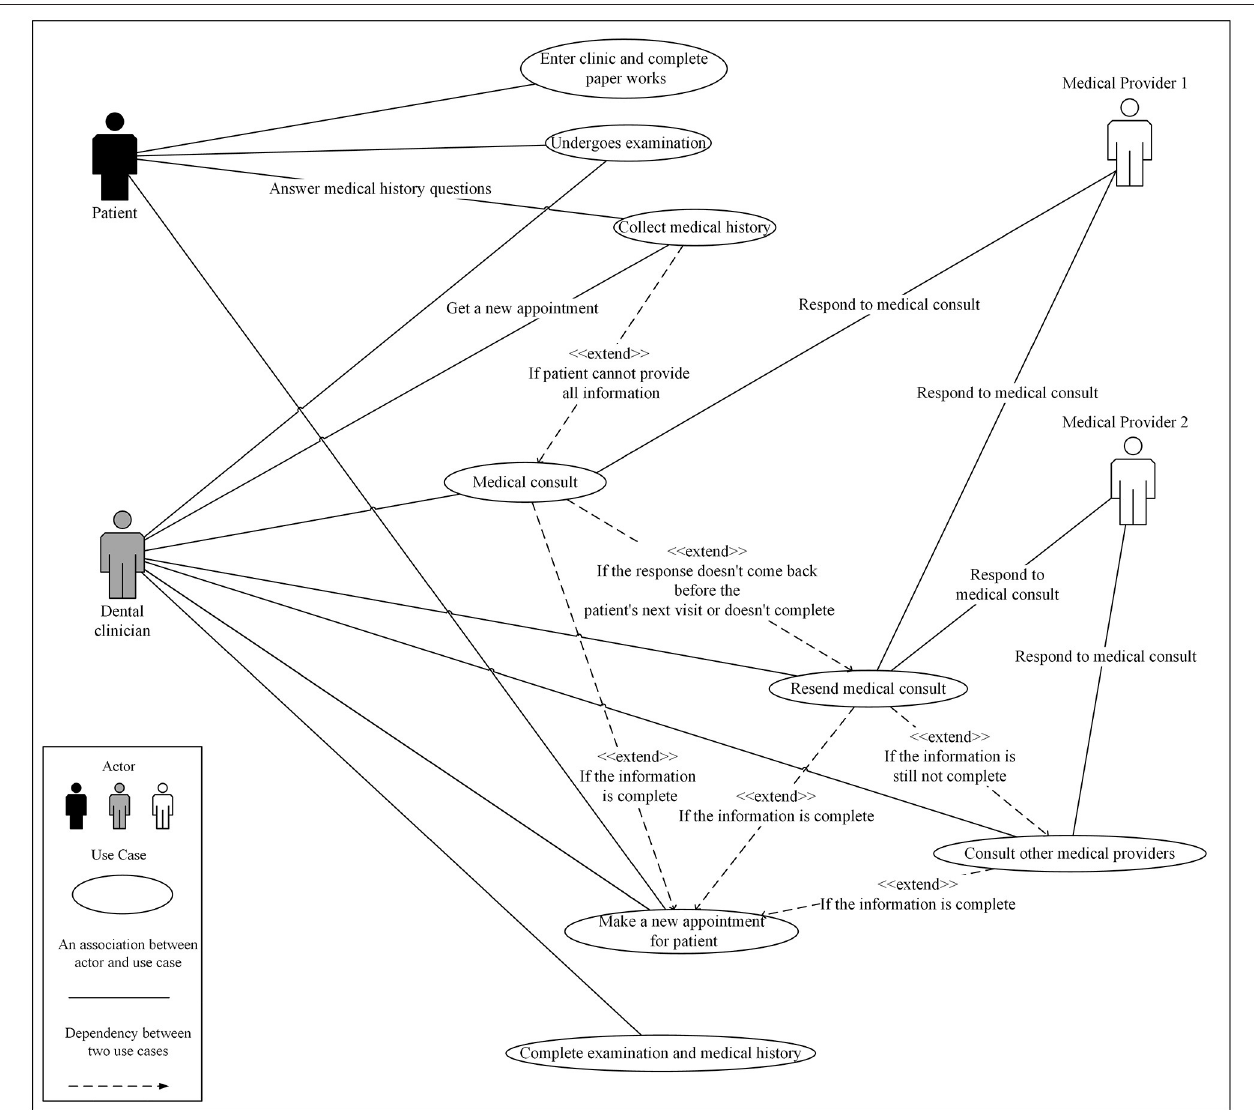
FIGURE 2 | Use case diagram for patient-reported medical history with optional medical consults approach in a dental clinic setting that uses an electronic dental record system and/or is not collocated with a medical clinic setting.